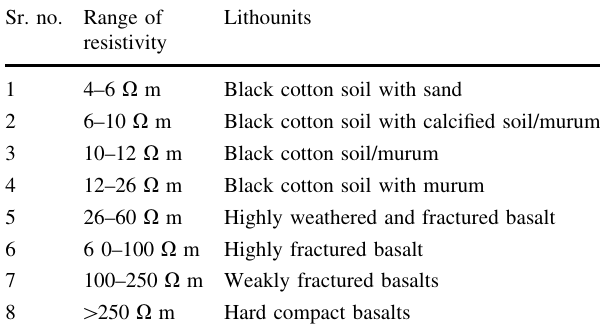
Table 2 Ranges of resistivity values of different lithounits